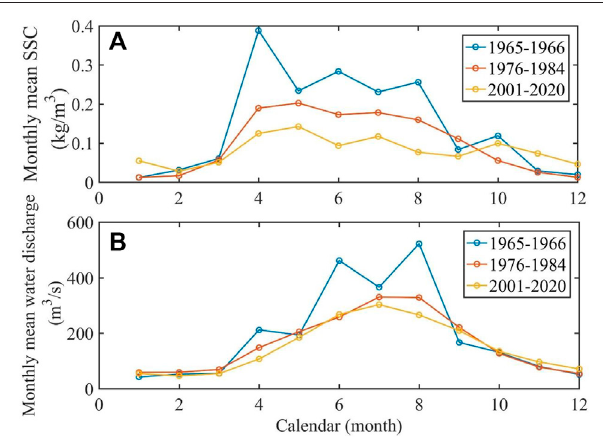
FIGURE 6 | Monthly mean SSC (A) and monthly mean water discharge (B) at the three stages.